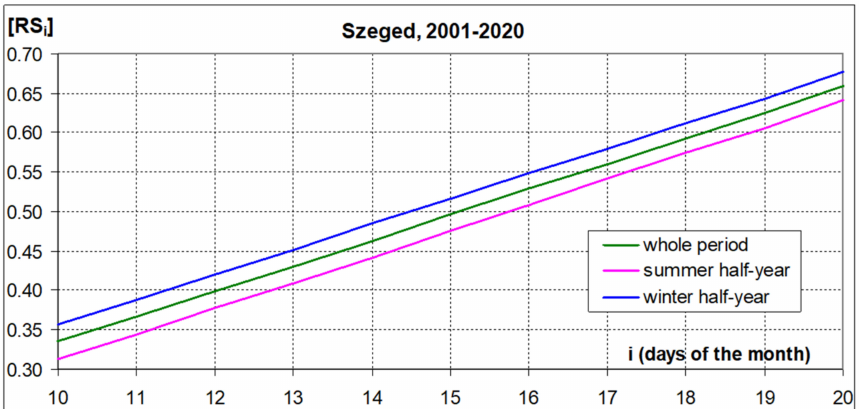
Figure 3. Time course of the average relative sliding sum [ RS i ] in the middle third of the